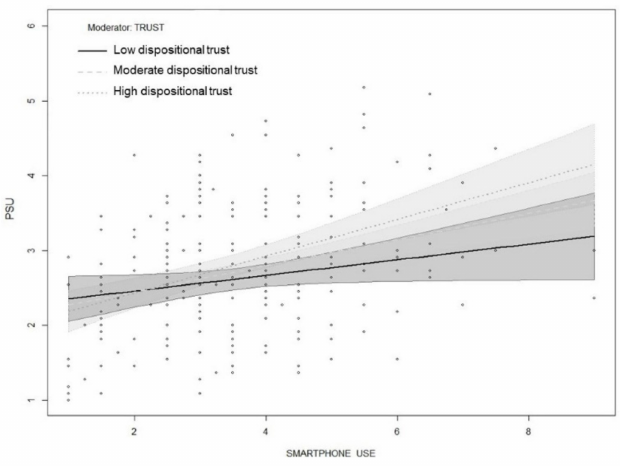
Figure 4. Interaction between smartphone use and dispositional trust on